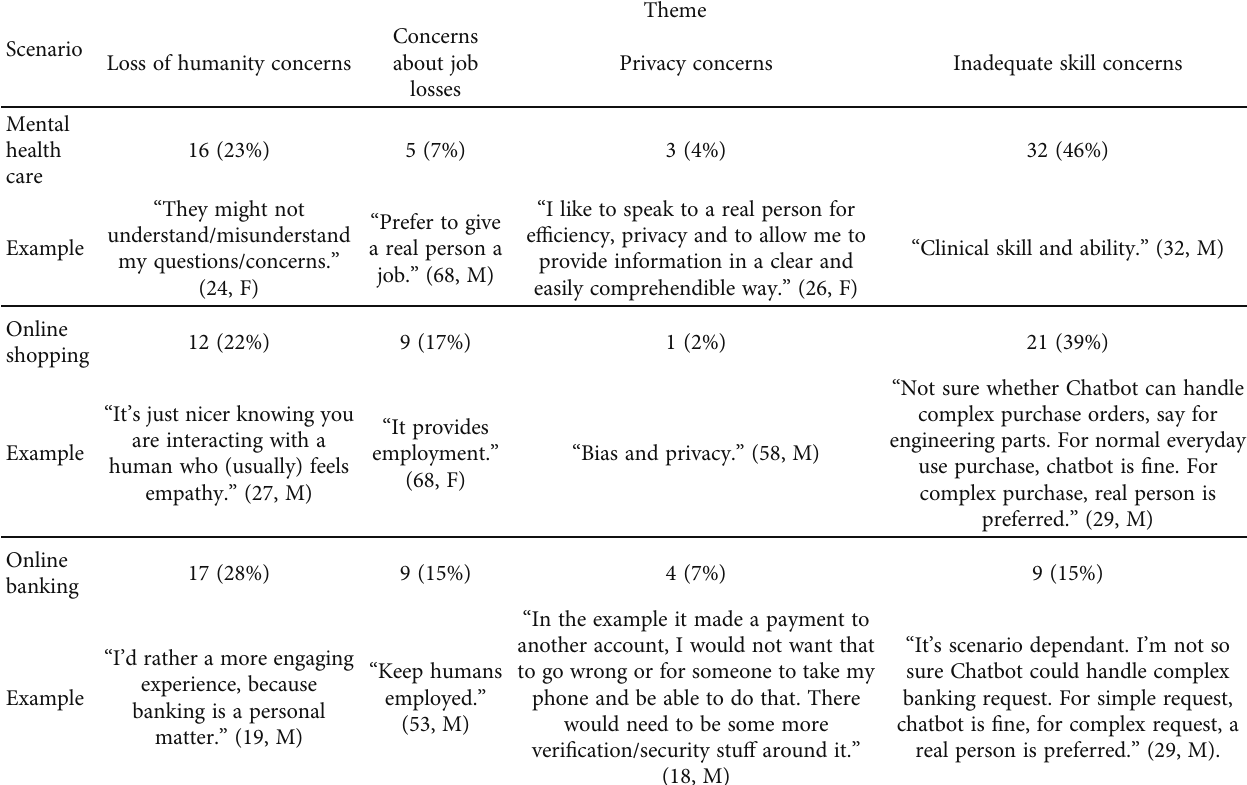
Table 7: Results from qualitative analysis.